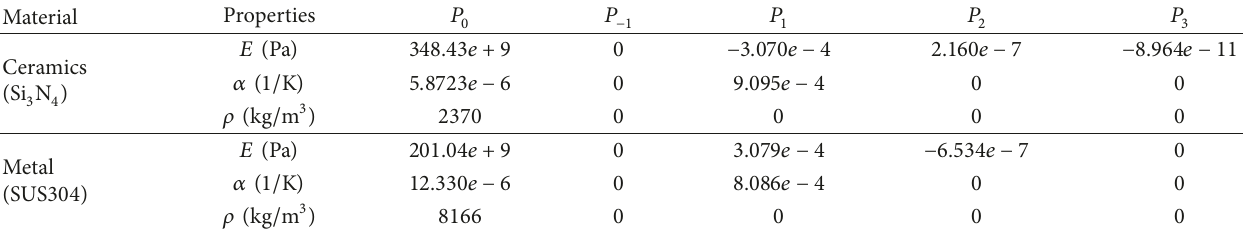
Table 1: The following SuS304/Si3N4 type of FGM properties are used for computation [30]. Material